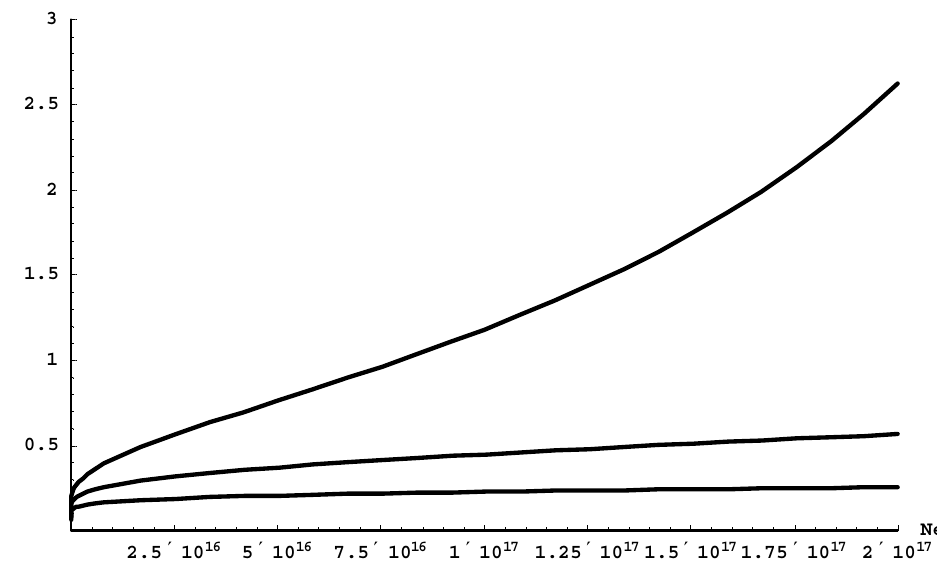
Figure 21. The ratio γ αβ ,hel / γ αβ ,rec for the electron densities below 2 × 10 17 cm − 3 for the Lyman-alpha line (the lower curve) and for the two intense π -components of |X αβ | = 10 of the Balmer-beta line (the middle curve). The upper curve shows the ratio γ αβ ,hel / γ αβ ,rec for the two most intense π -components of |X αβ | = 28 of the Balmer-delta line [101].